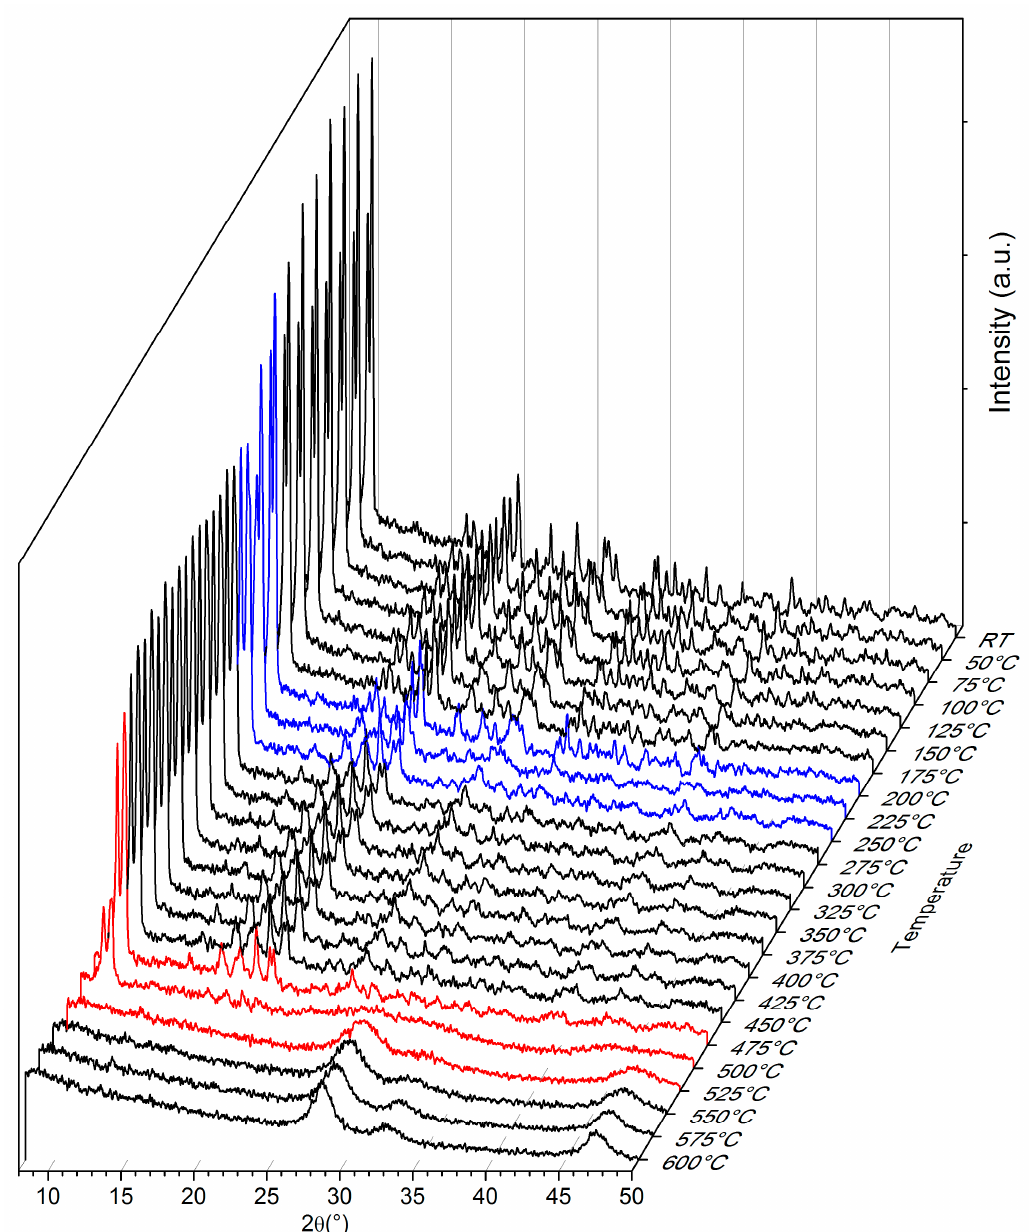
Figure 2. Variable temperature powder X-ray diffraction (VTXRD) recorded in the RT – 600 °C range in N 2 flow.